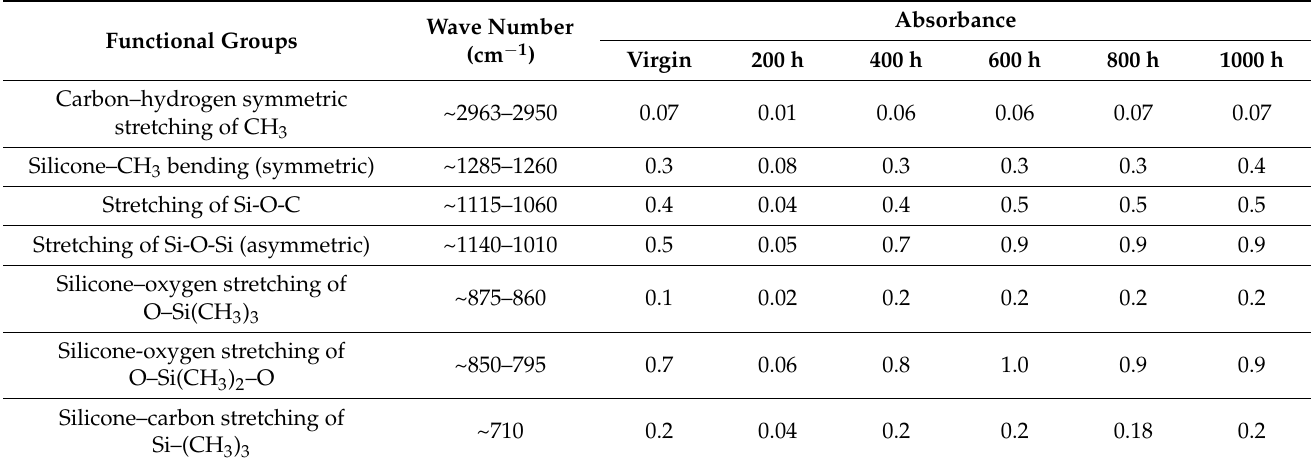
Table 3. Peak absorption of major groups in nSiR from virgin to 1000 h.